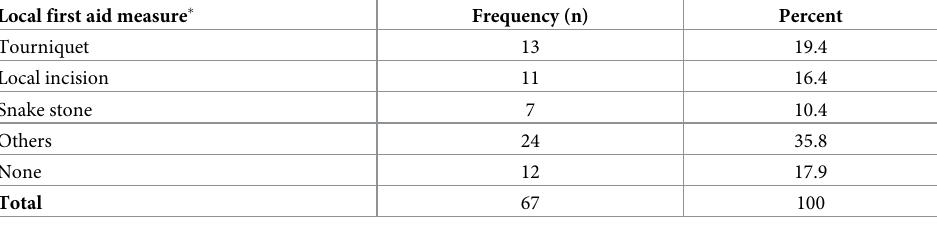
Table 3. The distribution of various traditional methods used following snakebite event in Meserani Juu (N = 67). Local first aid measure